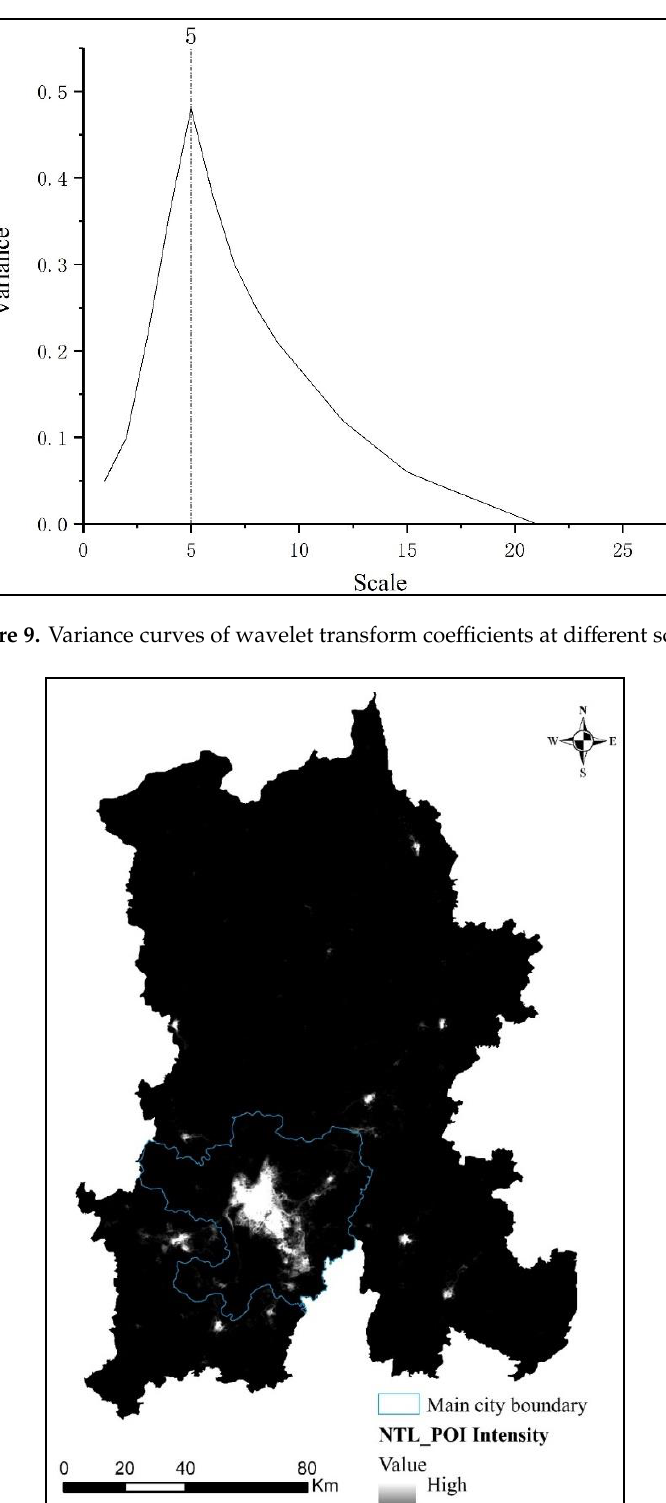
Figure 10. NTL_POI fused by wavelet transform.